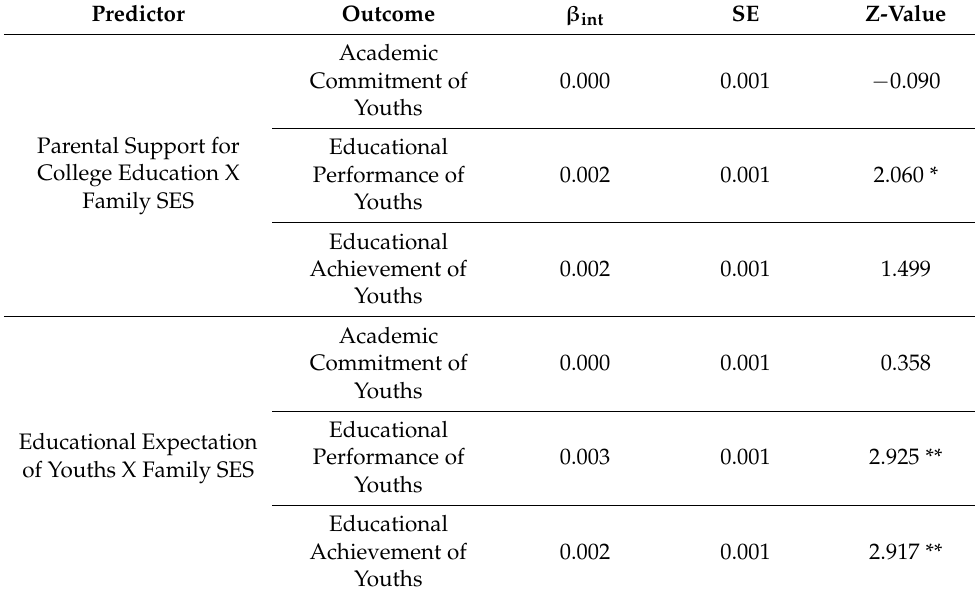
Table 5. Moderated Effects of Parental Support for College Education by Family SES and Educational Expectation of Youths by Family SES in Grade 7 on Youths’ Grade-8 Academic Commitment, Grade-9 Educational Performance, and Educational Achievement in Adulthood (Model